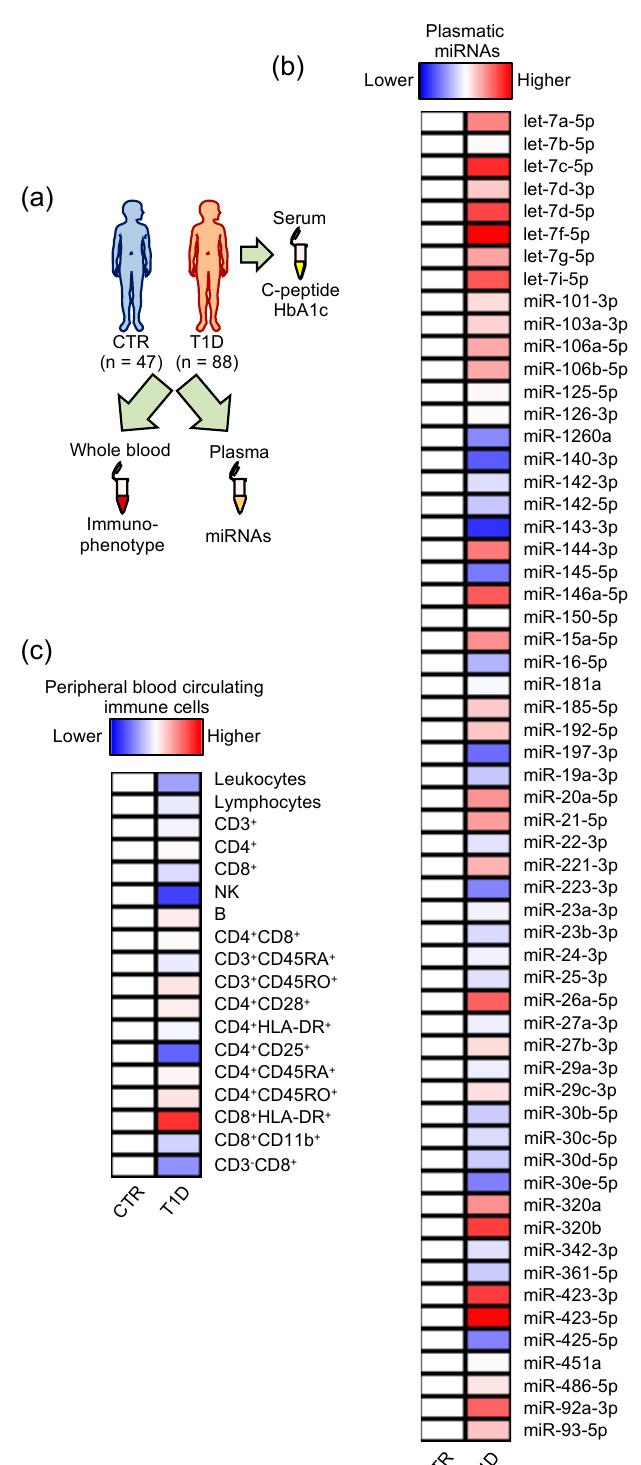
Figure 1. Schematic overview of the study. ( a ) Subjects recruited for the study and sample collection. (b,c) Heatmaps reporting the relative quantity of plasmatic microRNAs (miRNAs) profiled in the two groups of subjects (linear fold changes in T1D relative to CTR) ( b ) and peripheral blood circulating immune cells enumerated in the two groups of subjects and normalized by row (linear fold changes in T1D relative to CTR) ( c ). Maximum blue = 0.5 and maximum red = 1.5 linear fold change compared to CTR. Actual numbers are reported in Supplementary Table